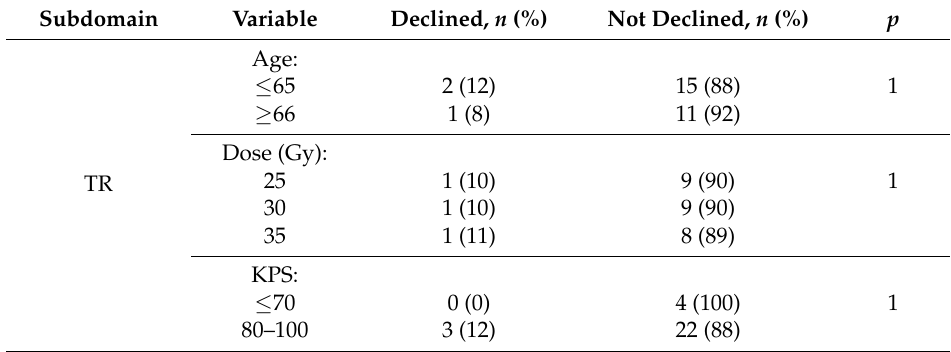
Table 6. Significant decline in eight-month individual HVLT-R scores and associated